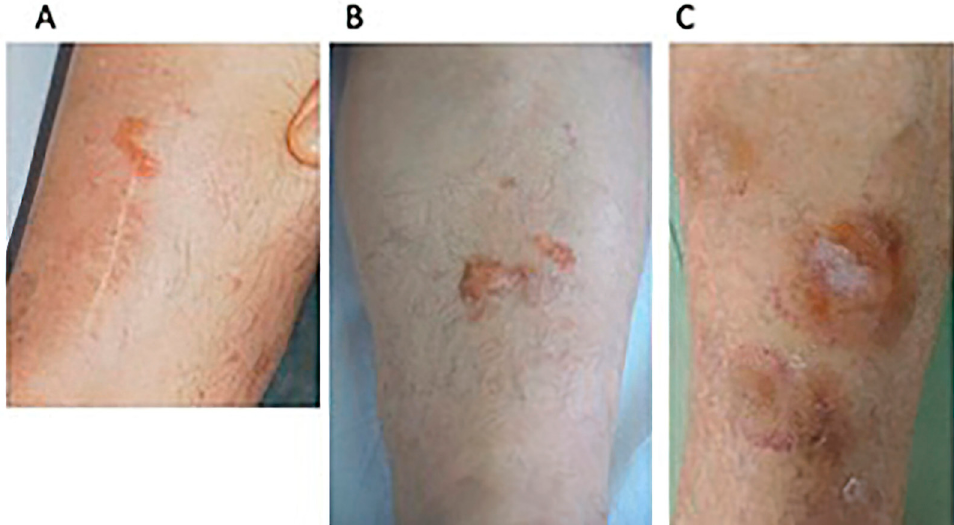
Figure 1. Clinical examination. ( A ) Case 1: residual well demarcated, linear orange-yellow plaque on the left leg with a white scar from a previous diagnostic biopsy; ( B ) Case 2: dome-shaped, yellow– pinkish nodule, and isolated papules of her left leg; ( C ) Case 3: multiple yellow–purple nodular lesions of the left leg .